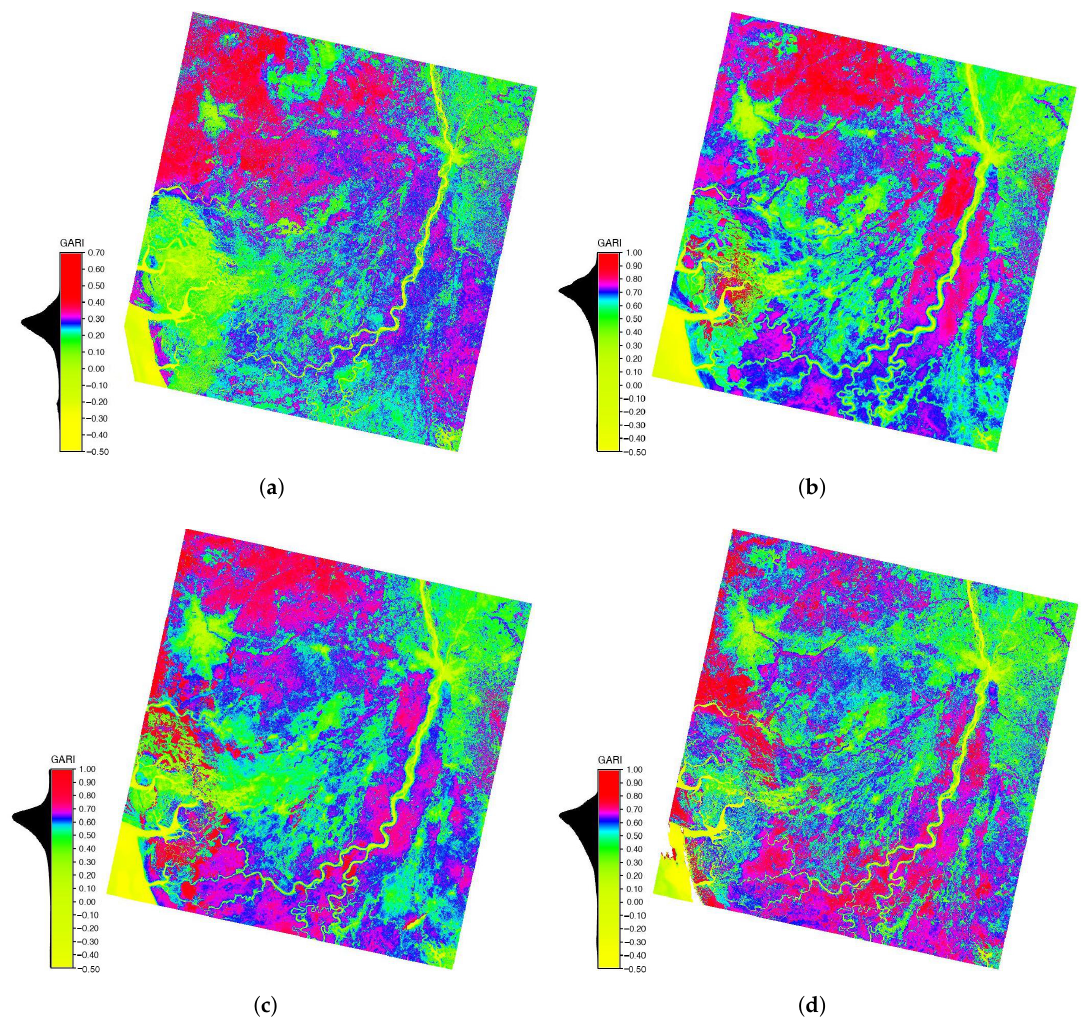
Figure 5. GARI computed from the Landsat 8-9 OLI/TIRS images of Niger River Delta for four years: ( a ) 2013, ( b ) 2015 ( c ) 2021, ( d )